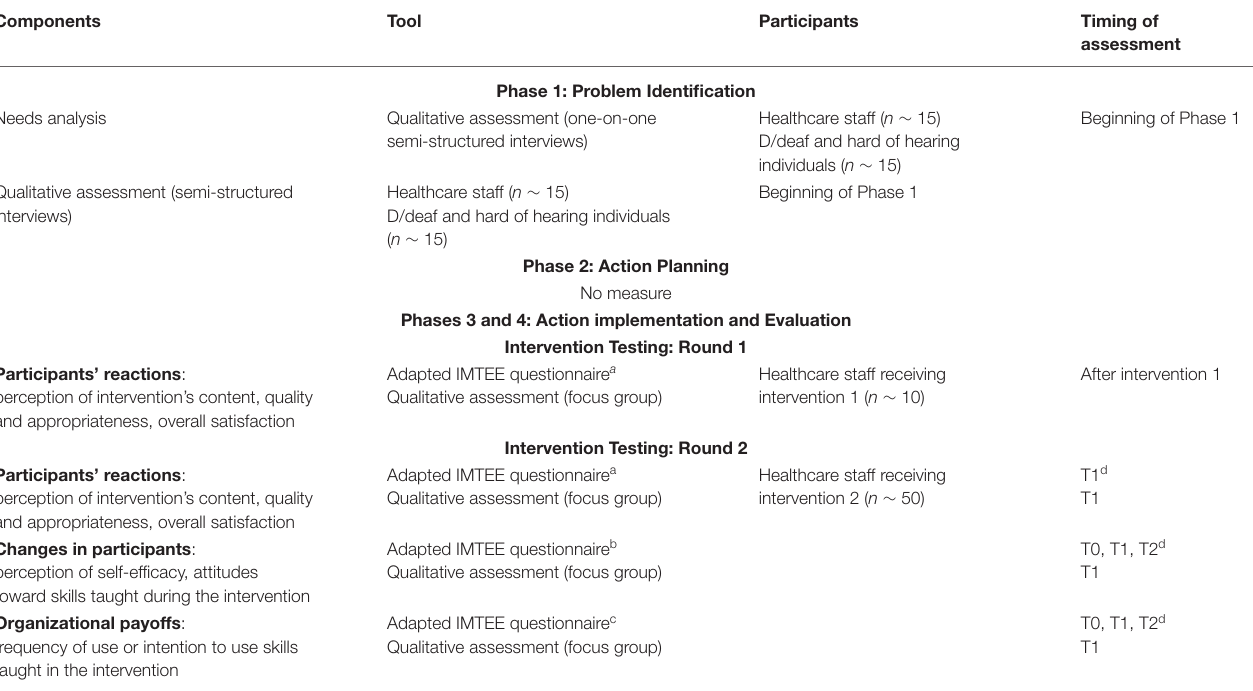
TABLE 1 | Summary of measures by action research